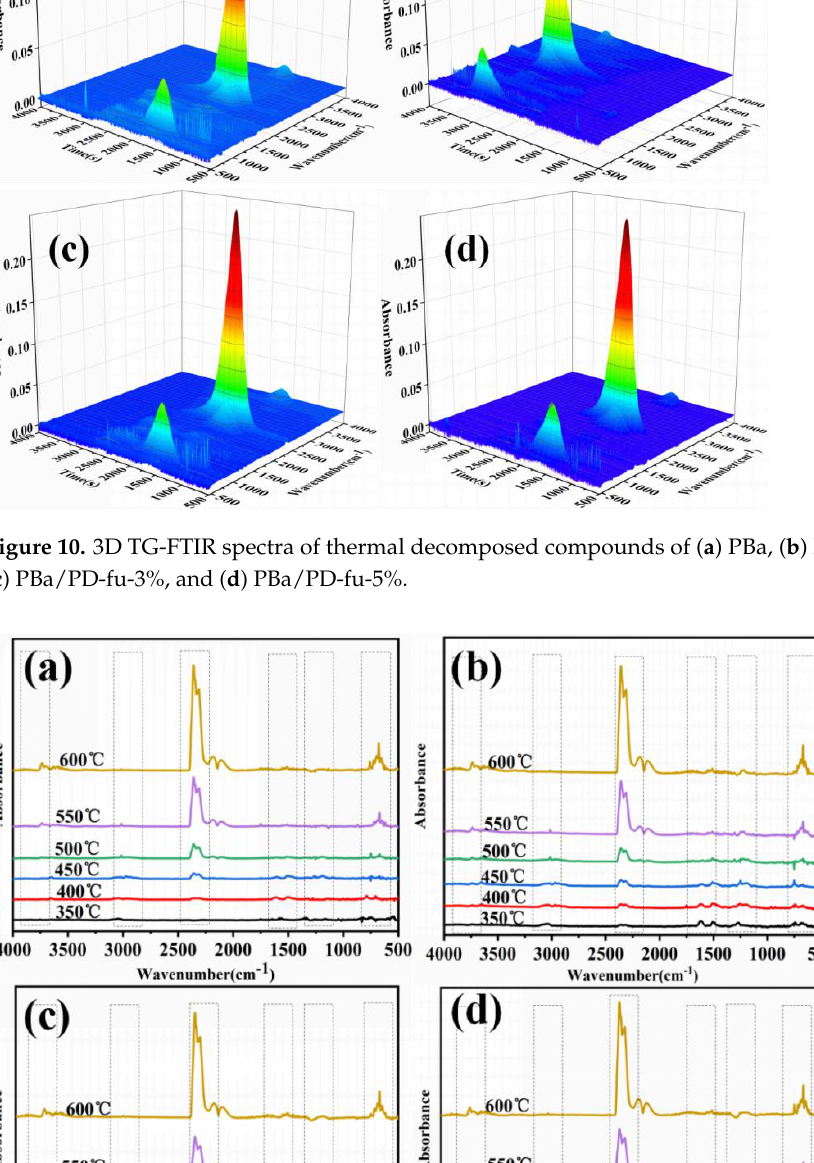
Figure 12. The analysis of pyrolysis products for neat PBa, PBa/PD-fu-1%, PBa/PD-fu-3% and PBa/PD-fu-5%: ( a ) water and ammonia gas, ( b ) alkane-containing compounds, ( c ) CO 2 , ( d ) CO, ( e ) and ( g ) aromatic compounds, ( f ) and ( h ) P – O and P=O compounds.